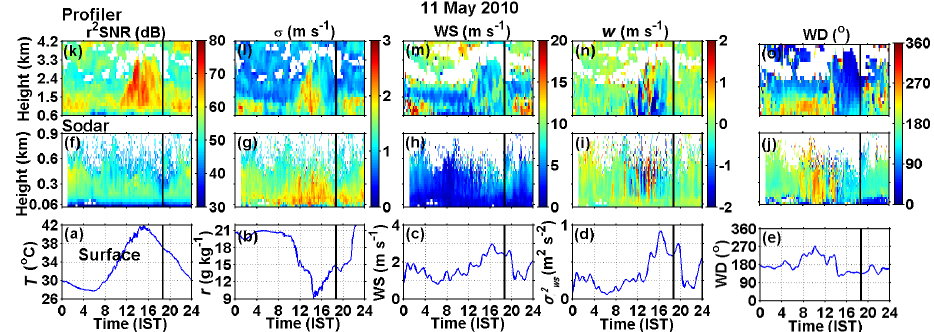
Figure 1. Diurnal variation of state variables at the surface and aloft on 11 May 2010, MBLM-derived surface (a) T , (b) r , (c) WS (d) σ 2 and (e) WD and sodar-derived (f) range-corrected SNR, (g) σ , (h) WS, (i) w and (j) WD. (k – o) Same as (f – j) , except for profiler-derived state variables. The solid vertical line indicates the time of sunset.